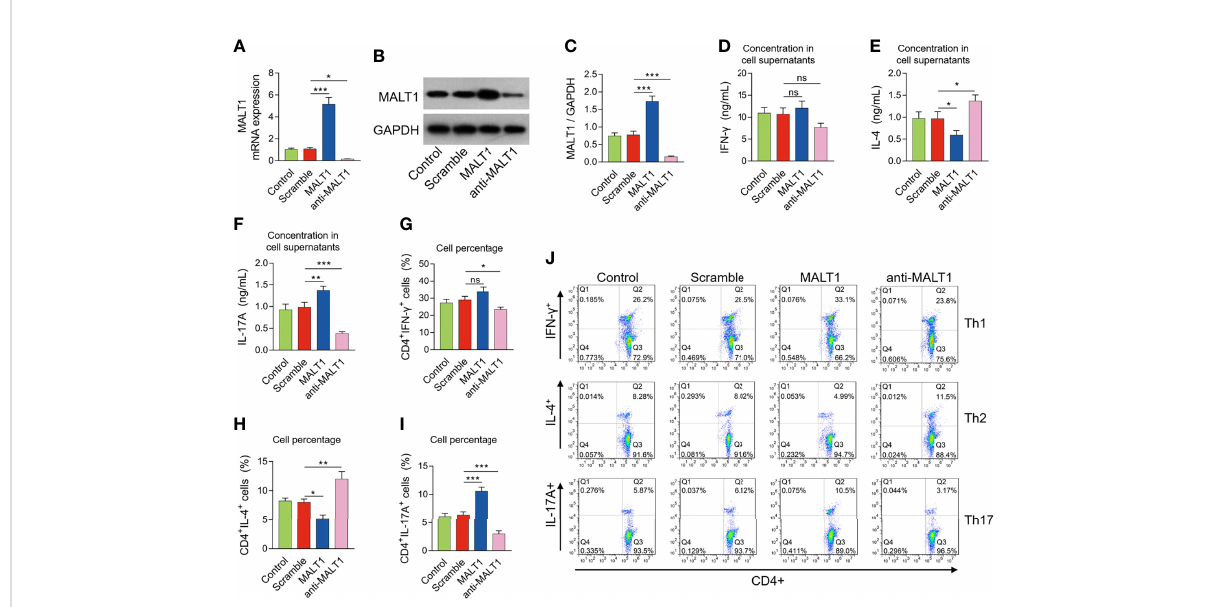
FIGURE 5 Effect of MALT1 on Th1/2/17 cell differentiation in RA. MALT1 mRNA expression (A) , MALT1 protein expression (B, C) after lentivirus transfection. IFN- g level (D) , IL-4 level (E) , IL-17A level (F) in cell supernatants, percentage of CD4 + IFN- g + cells (G) , CD4 + IL-4 + cells (H) , CD4 + IL-17A + cells (I) after lentivirus transfection. Examples of fl ow cytometry image after lentivirus transfection (J) . * meant P<0.05, ** meant P<0.01, *** meant P<0.001, ns meant not signi fi cant.